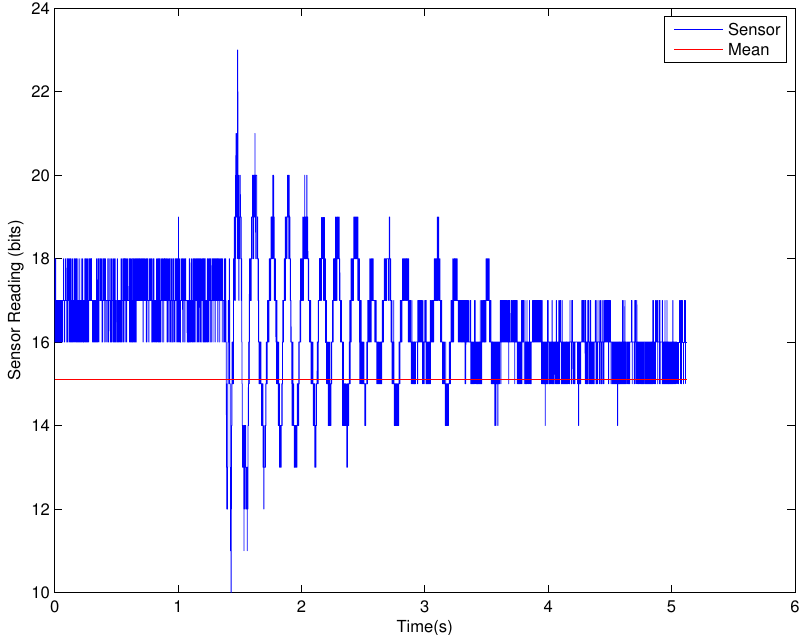
Figure 9. Sensor measurements from test using robotic arm with emergency